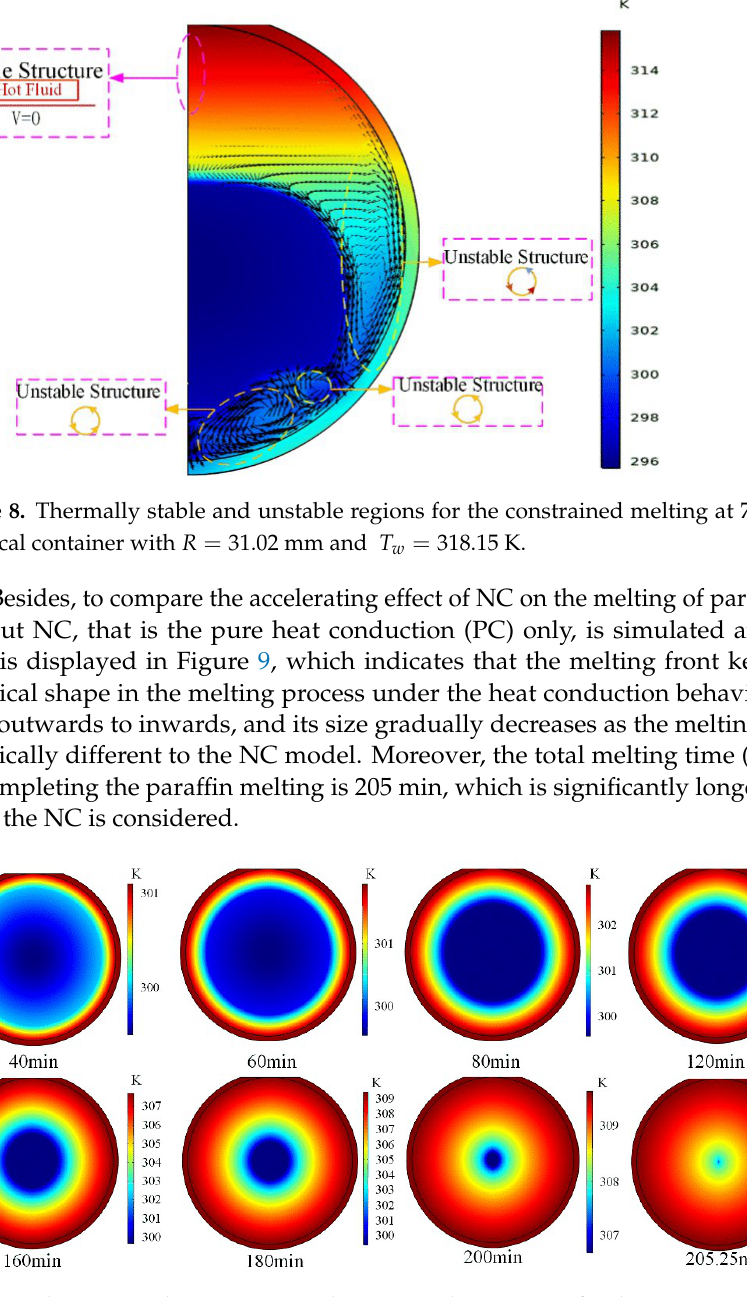
Figure 9. The PCM melting process without natural convection for the constrained melting inside the spherical container with 𝑅 = 31.02 mm and 𝑇 (cid:3050) = 318.15 K .